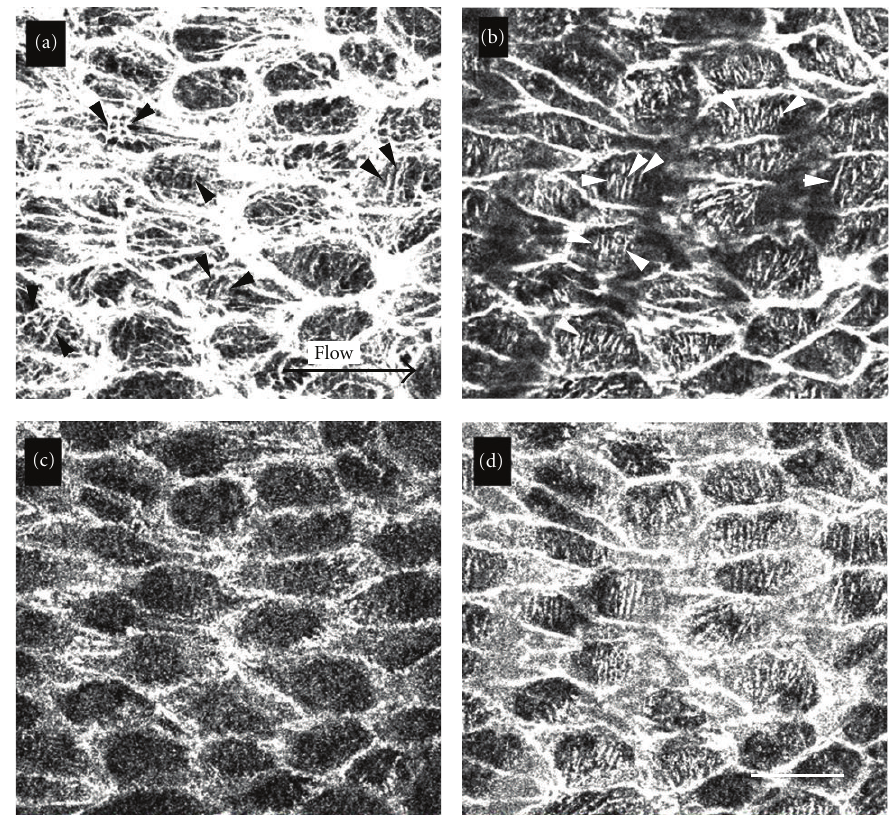
Figure 1: En face preparations of the renal artery were double-stained with rhodamine-labeled phalloidin (a and b) and antivinculin antibody (c and d). Focus was adjusted to apical (a and c) and basal (b and d) portions of the endothelial cells. In the apical portion of the cells, several stress fibers running perpendicular to the direction of flow were observed (a: arrowheads) among the stress fibers running parallel to the direction of flow (a: arrow). Only stress fibers running perpendicular to the direction of blood flow were seen in the basal portion of the cells (b: arrowheads). All spots showing positive labeling with antivinculin antibody were colocalized with stress fibers (d). Bar: 100 µ